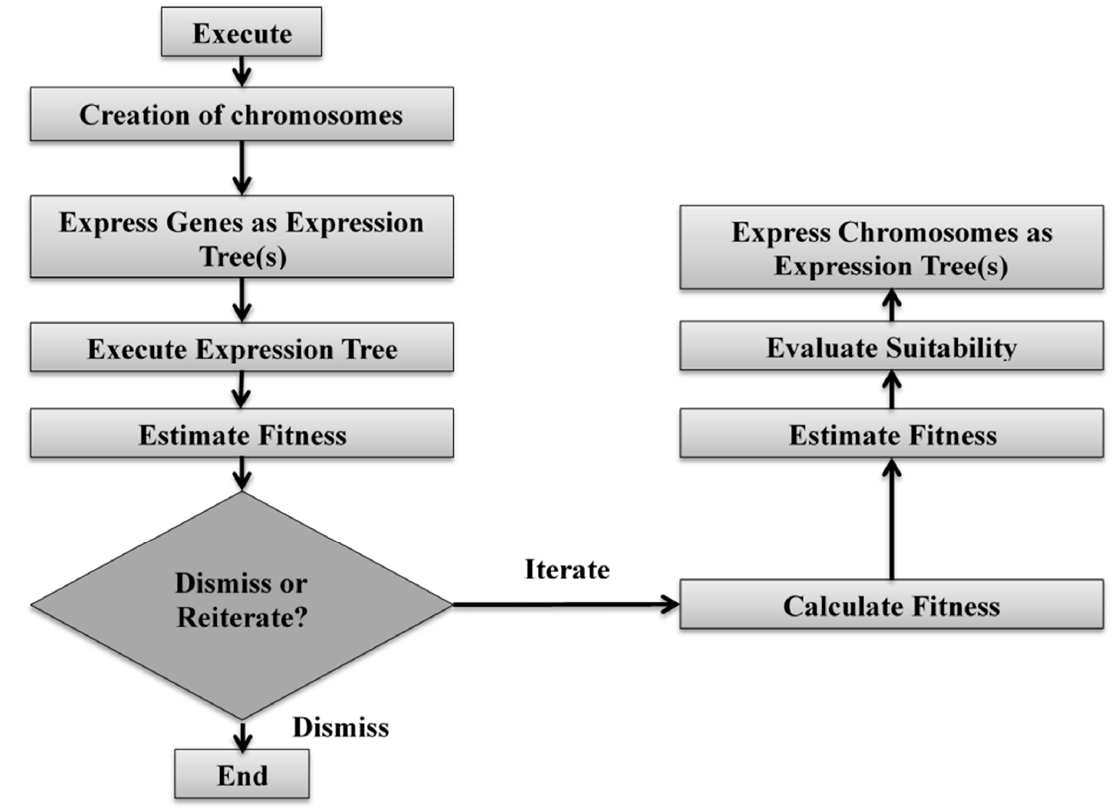
Figure 4. Schematic diagram of GEP algorithm.